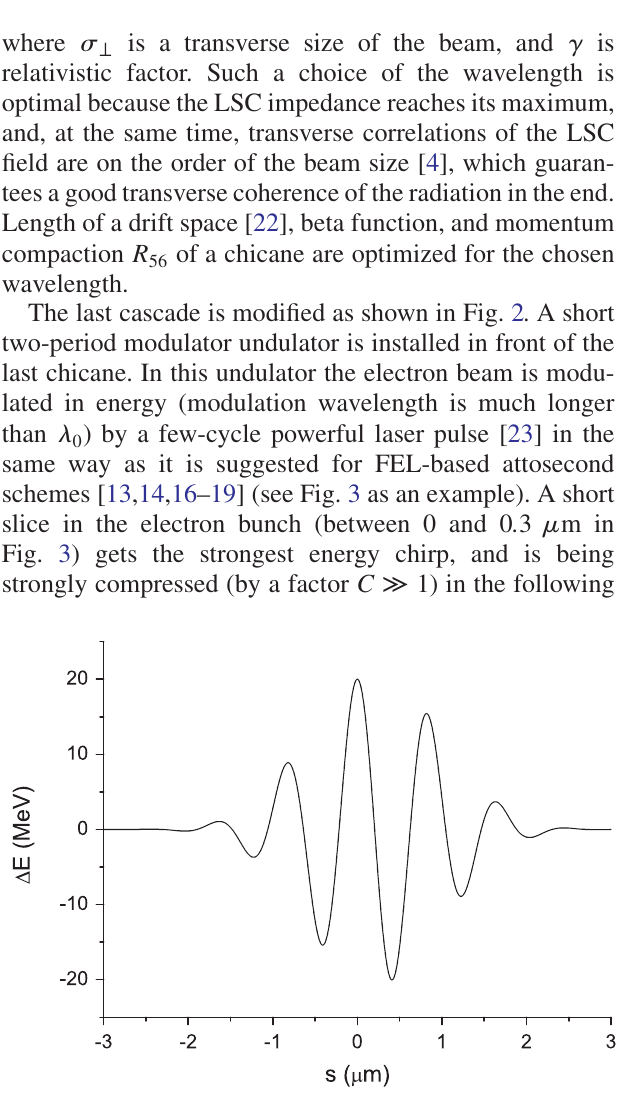
FIG. 3. Energy modulation, induced on the beam by a short laser pulse in a two-period undulator. Energy deviation is plotted as a function of the longitudinal position in an electron bunch.